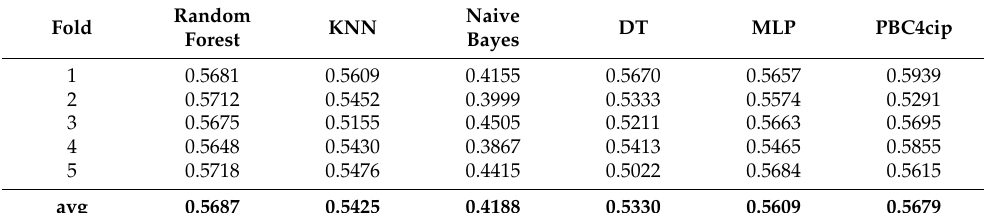
Table 5. Cross-validation CEM results